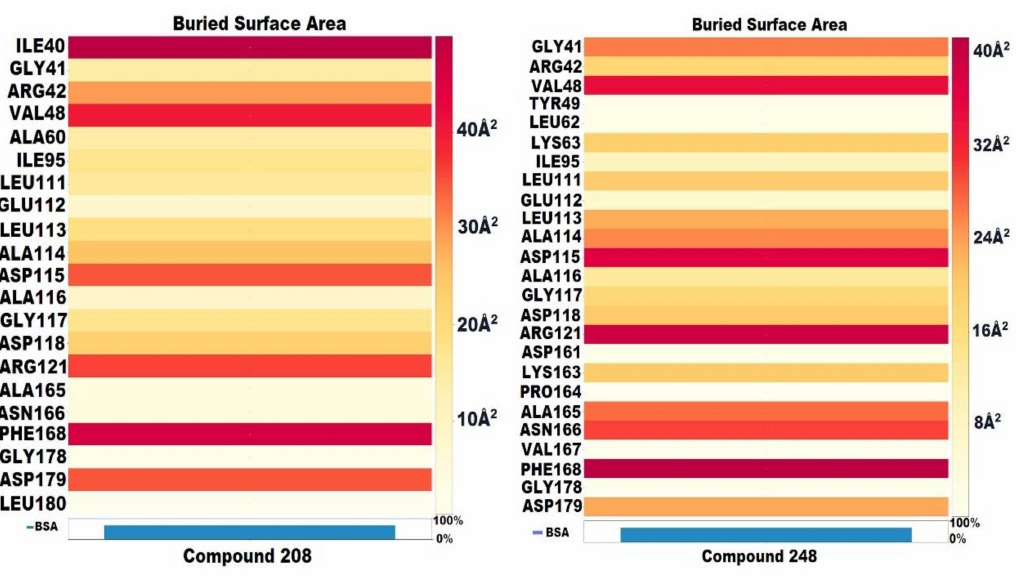
Figure 9. Buried surface area (BSA) of compound 208 and 248 .